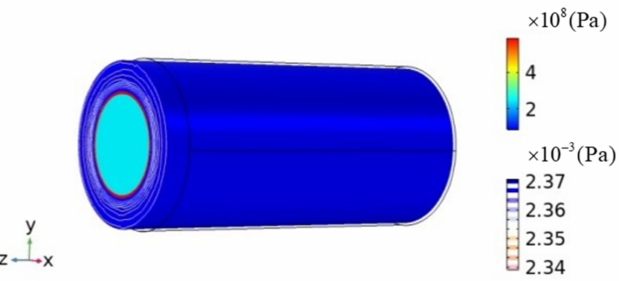
Figure 12. von Mises stress and effective plastic strain (isoclines) distributions of the EAS-Nb 3 Sn strand considering fiber damage at T = 4 K and axial strain ε =